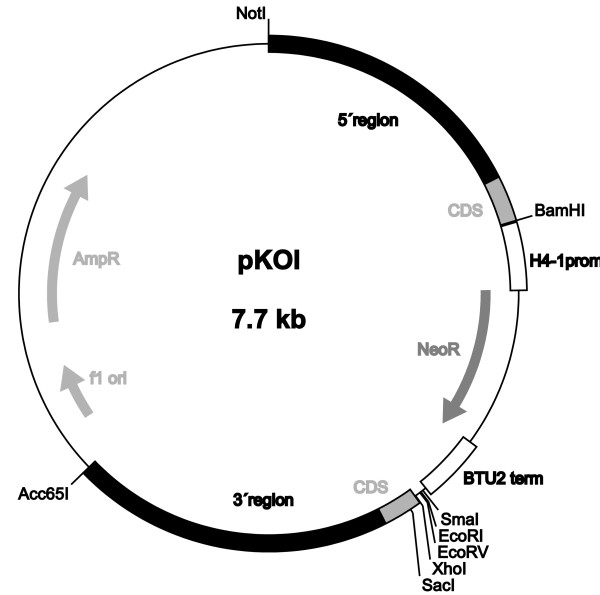
pKOI: The basis for a DHFR-TS knock out construct. Figure 3 shows the knock out construct used for a targeted knock out of the DHFR-TS gene in T. thermophila. It consists of 3' and 5' flanking regions of the T. thermophila DHFR-TS gene and parts of its coding sequence (CDS), disrupted by a functional neomycin cassette conferring resistance to paromomycin. For more details refer to material and methods section.